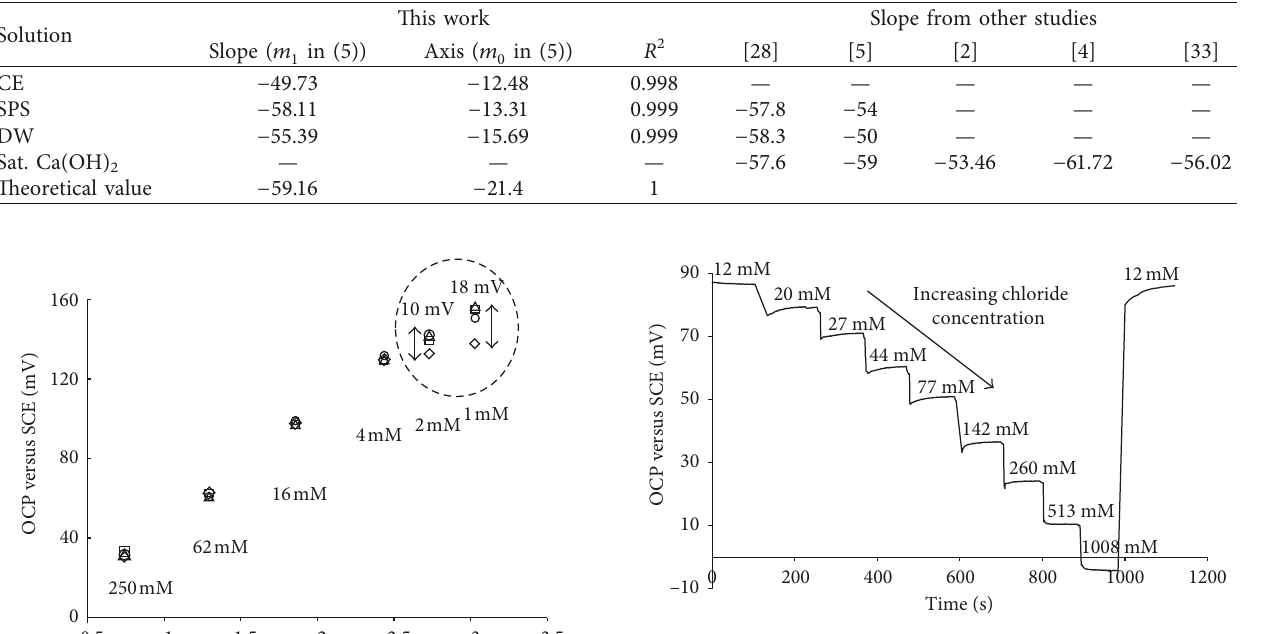
Figure 7: Chloride sensor’s response in cement extract solution (CE) at continuously changed chloride